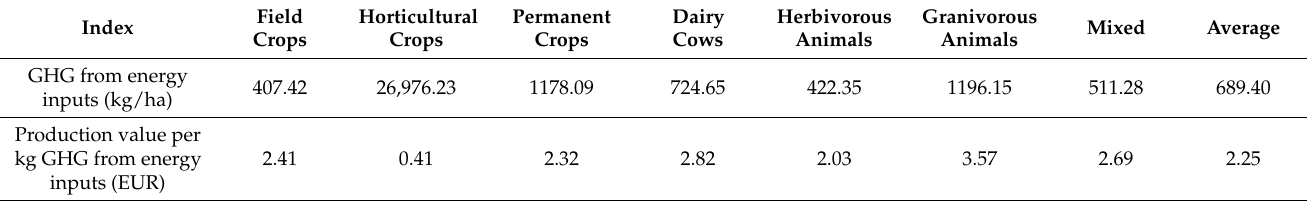
Table 7. Emission from energy inputs per 1 ha of agricultural land and production value per 1 kg of GHG from energy inputs.